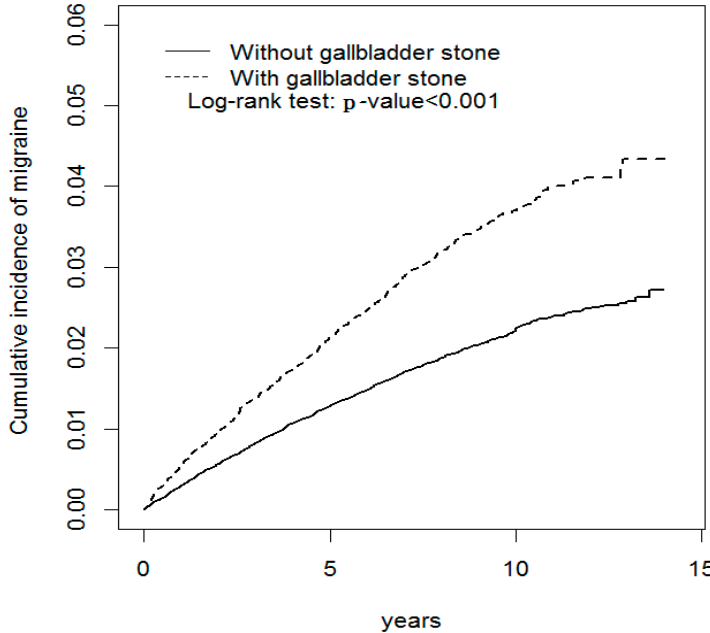
Figure 1. Cumulative incidence comparison of migraines for patients with (dashed line) or without (solid line) gallbladder stone disease. Table 1. Demographic characteristics and comorbidities in cohorts with and without gallbladder stone disease.